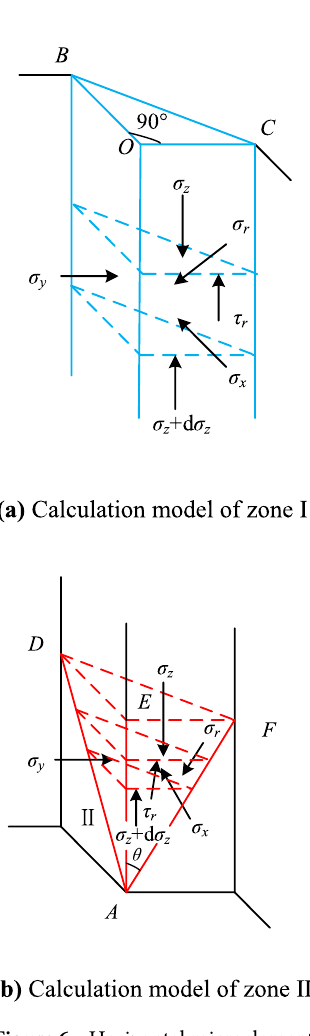
Figure 6. Horizontal microelement stress state of the external corner when B < H tan θ